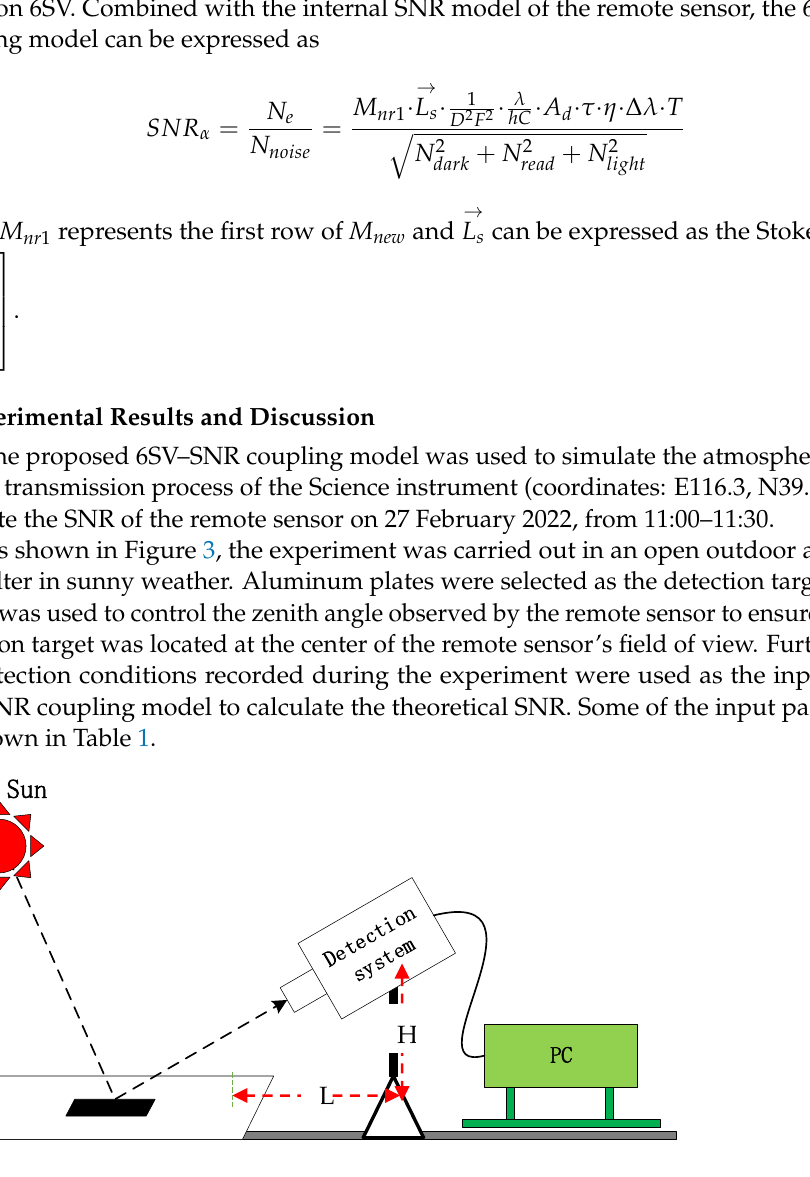
Figure 3. Simulation diagram of the experimental process. In the experiment, natural light was used as the light source input in an open outdoor area with no shelter. Images under different detection conditions were collected by PC and images were collected in a short time. L is the horizontal distance between the detection system and the target, H is the vertical distance between the detection system and the target, and both are about 1.5 m. Table 1. The input parameters ( the detection conditions recorded).